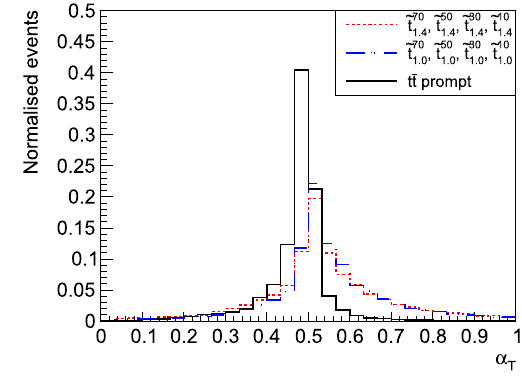
Fig. 48 (cid:6) R distributions in the stop squark ˜ t case